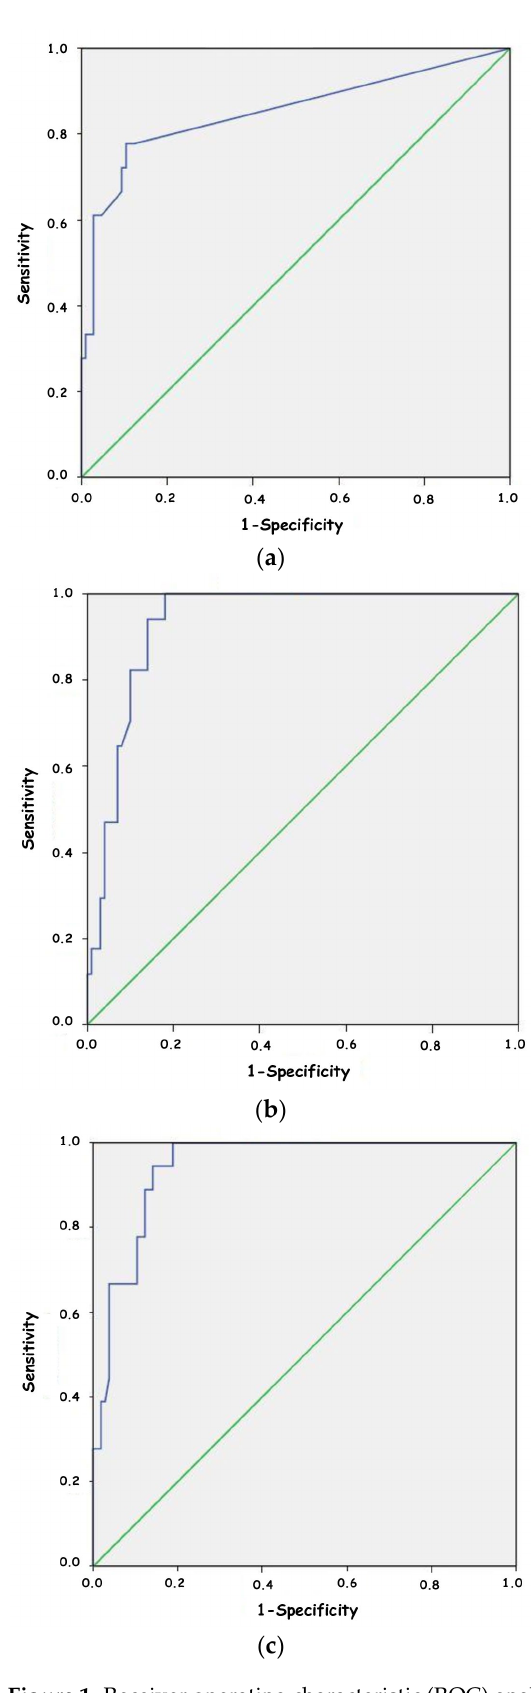
Figure 1. Receiver operating characteristic (ROC) analysis. ( a ) Basal Tg, optimal cutoff = 0.39 ng/mL. Area under the ROC curve (AUC)= 0.852. Sensitivity, specificity, accuracy, positive predictive